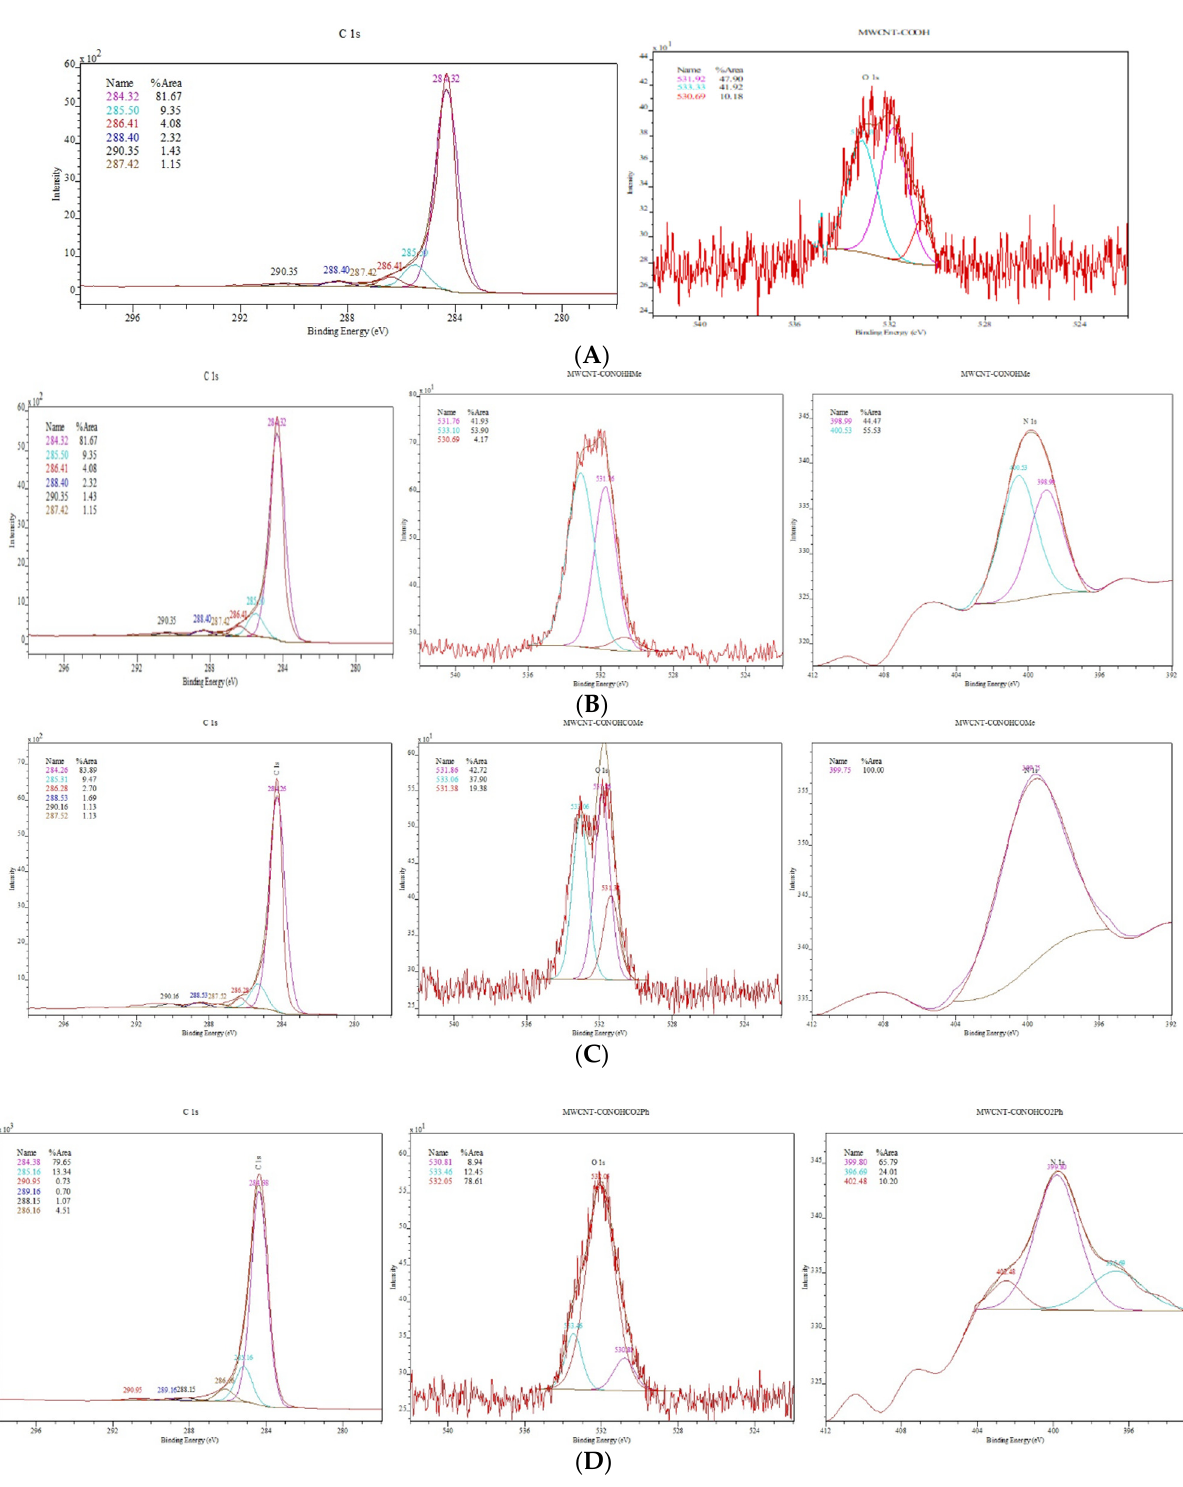
Figure 5. X-ray photoelectron spectroscopy (XPS) profiles of ( A ) MWCNT-COOH, ( B ) MWCNT- CONOHMe, ( C ) MWCNT-CONOHCOMe, and ( D ) MWCNT-CONOHCOPh.